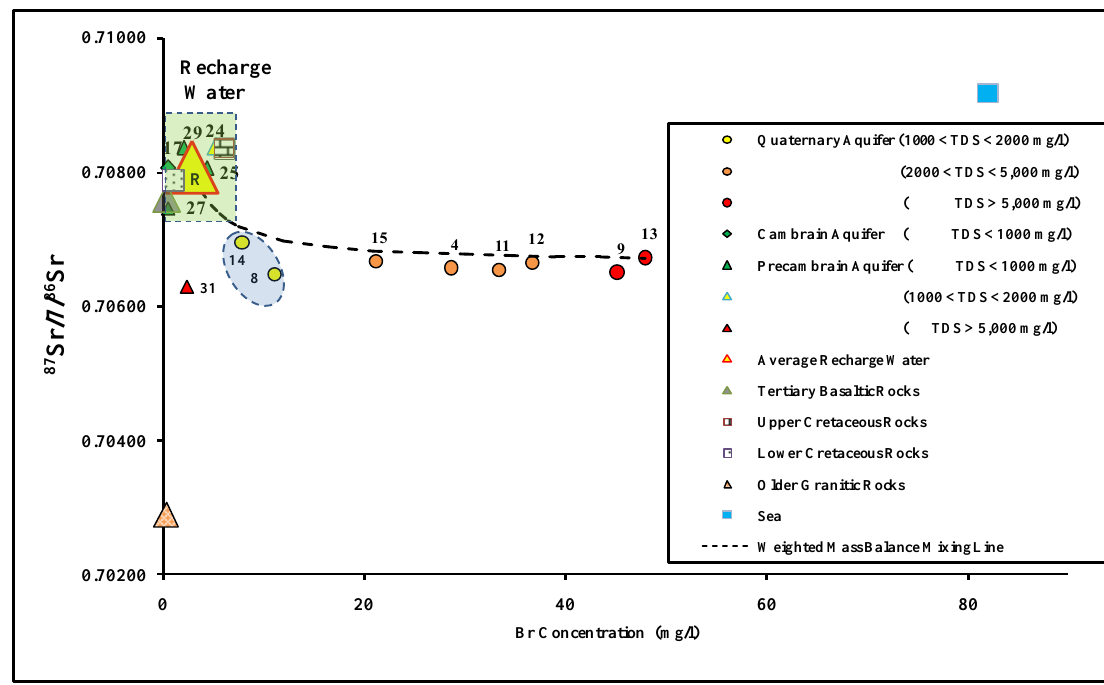
Figure 9. 87 Sr/ 86 Sr versus bromide concentrations values of the groundwater in the Dahab watershed.